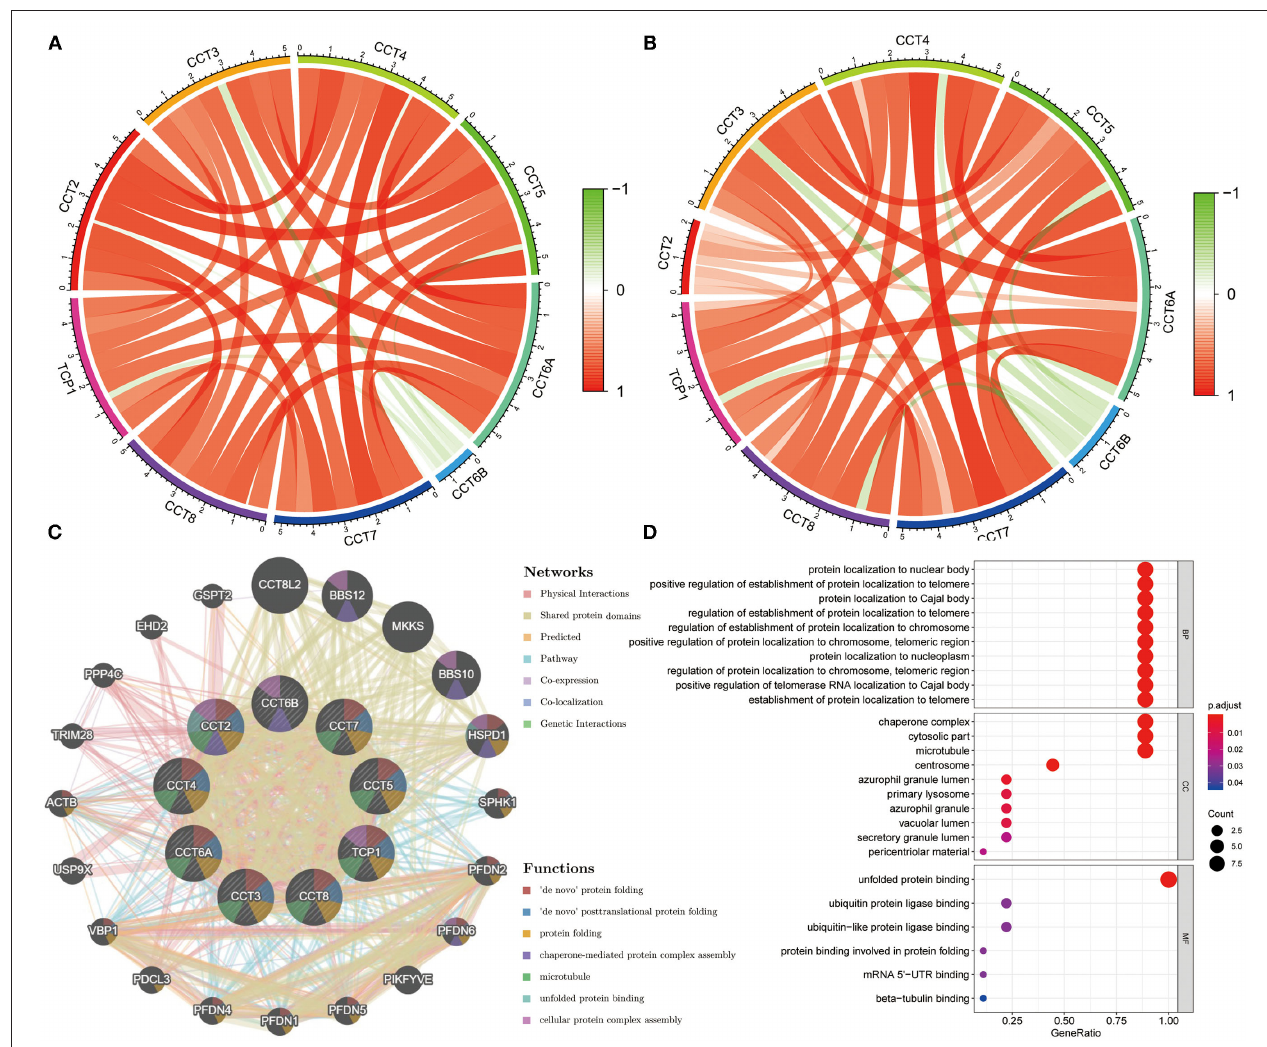
FIGURE 4 | Expression correlation among CCT subunit genes and protein-protein interaction (PPI) network analysis of CCT subunit proteins. (A) Expression correlation among CCT subunit genes in the TCGA cohort. (B) Expression correlation among CCT subunit genes in the ICGC cohort. (C) PPI network of CCT subunit proteins in the GeneMANIA database. (D) Gene ontology and pathway enrichment analysis of CCT subunit